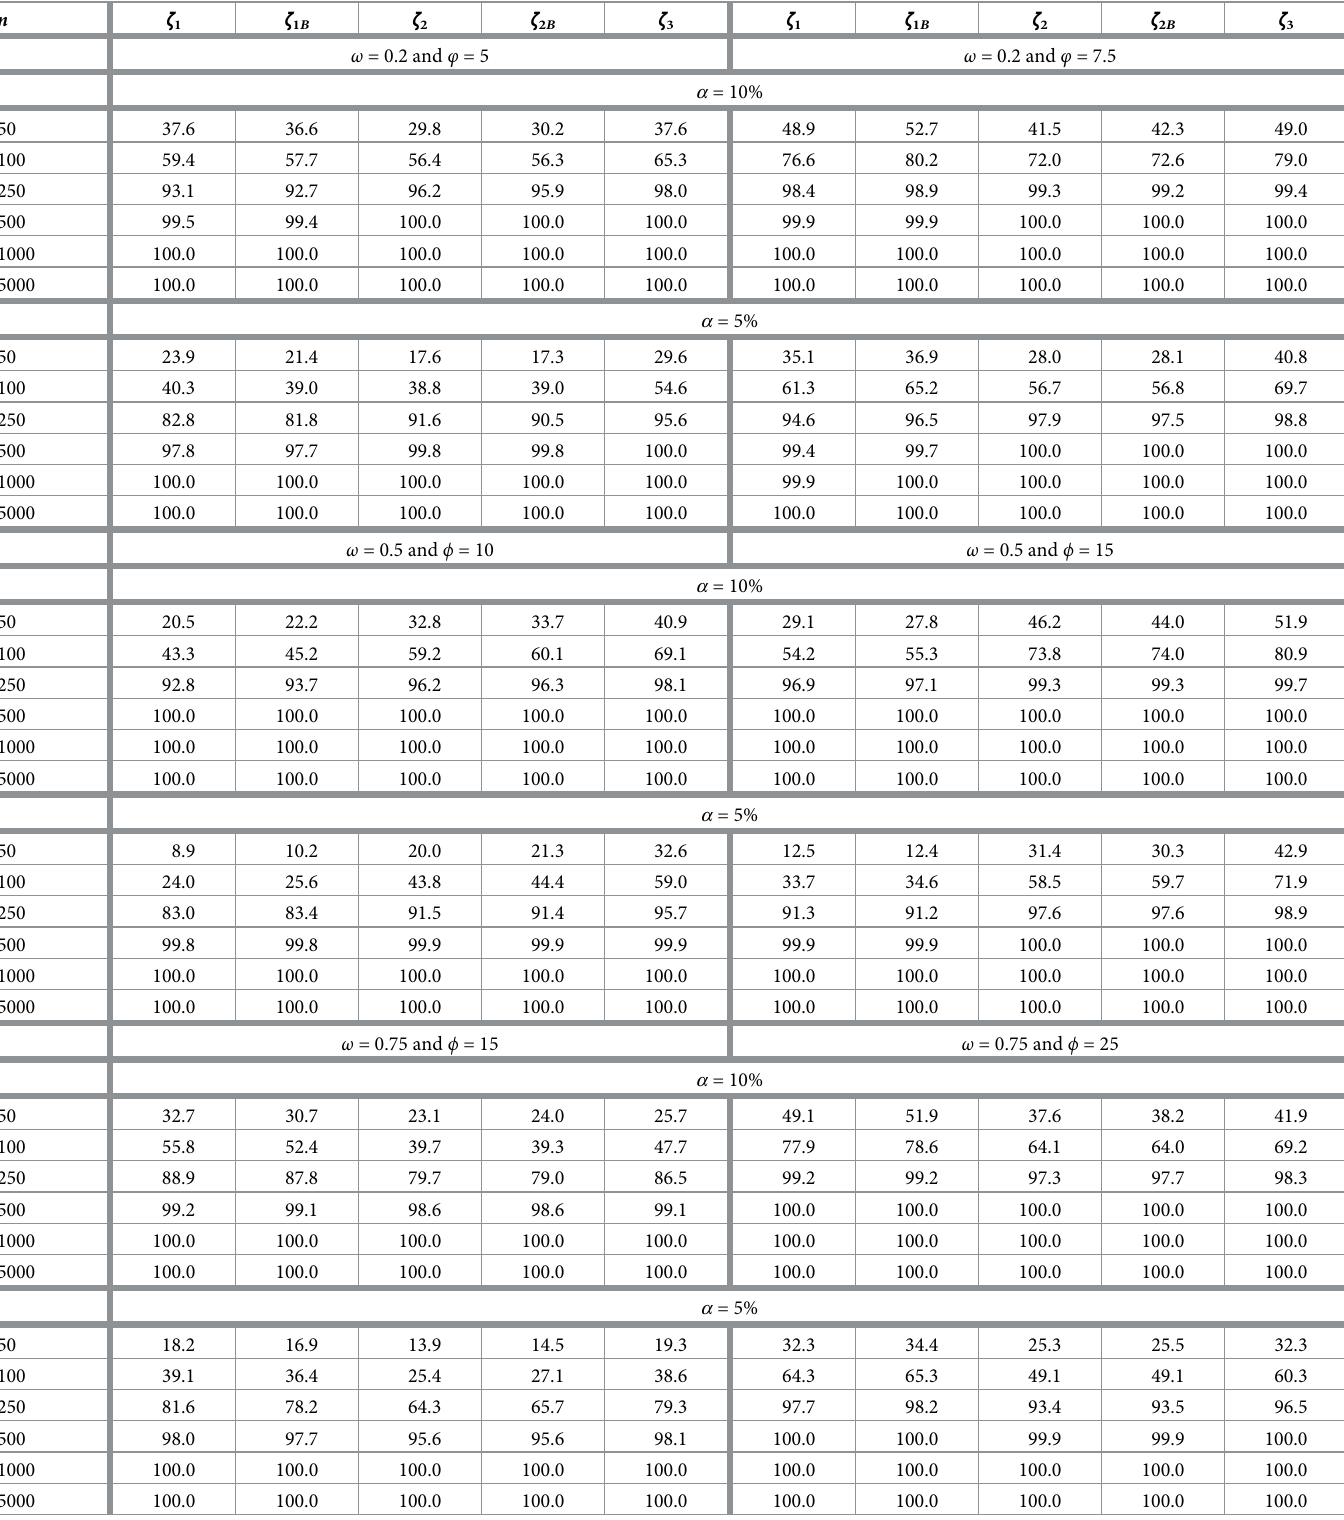
Table 4. Non-null rejection rates (%), data generated from KW ð ω ; ϕ Þ